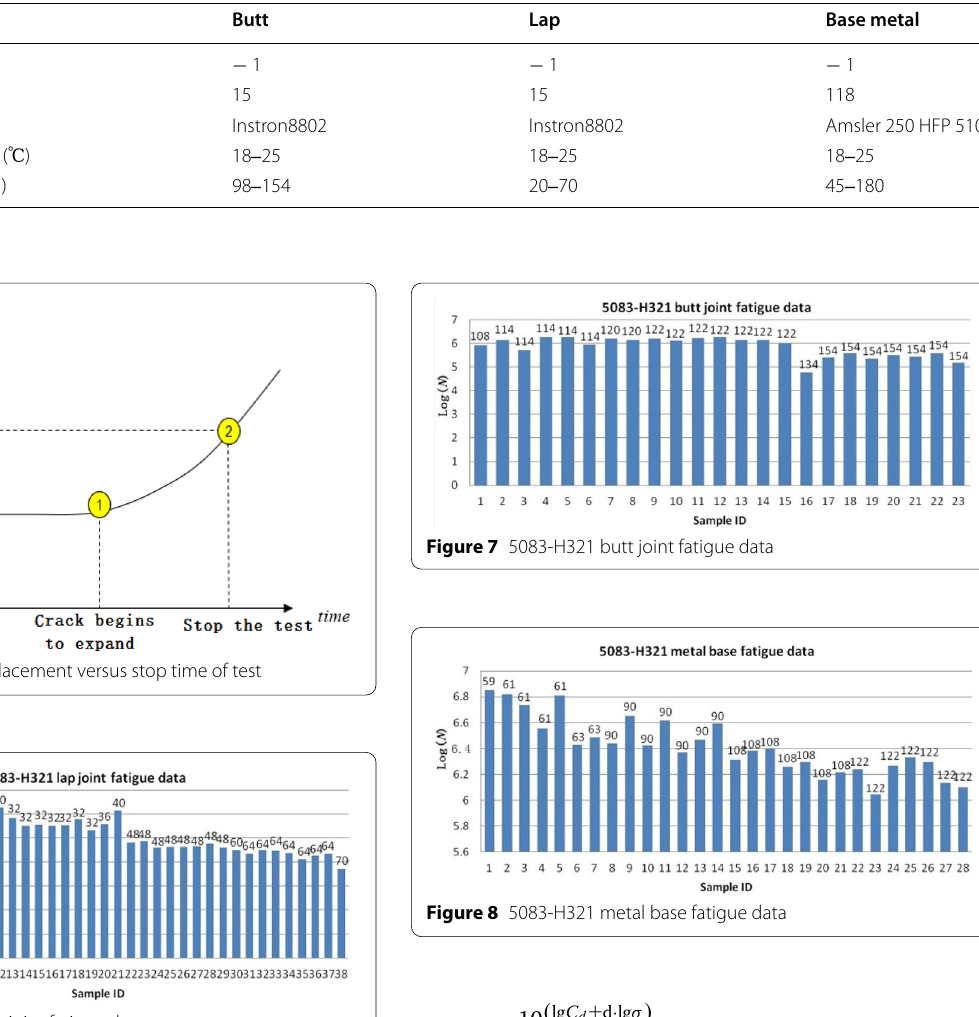
Figure 6 5083-H321 lap joint fatigue data